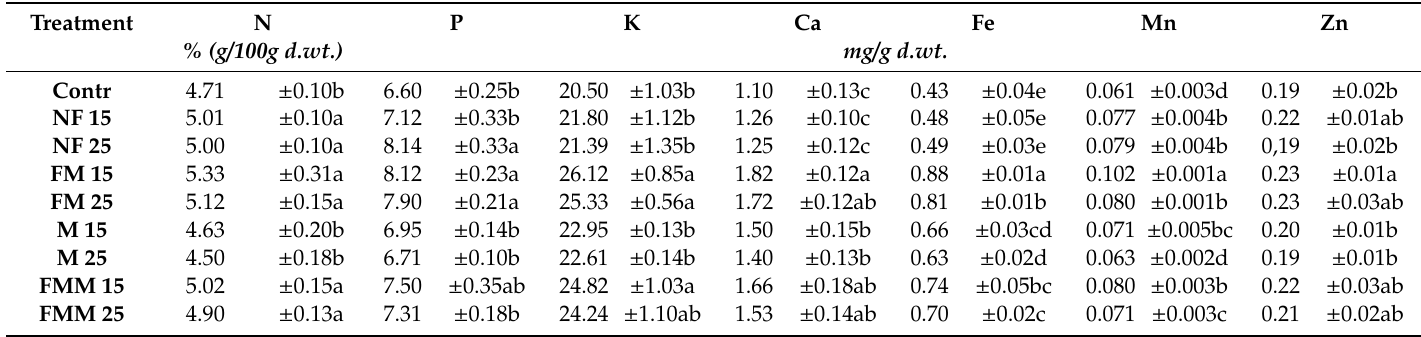
Table 2. Leaf elemental composition of plants supplied for 48 h with HS extracted from earthworm coprolites collected in soil plots fertilized with no inputs (NF), manure (FM), mineral fertilizers (M) and with manure plus mineral fertilizers (FMM). Data for N, P, and K are expressed in percent (g / g dry weight), while for other nutrients they were expressed in mg / g dry weight. Data represent the means of three measurements with ten plants in each. Values in the same column following the same letter are not statistically di ff erent at p < 0.05 according to Student-Newman-Keuls